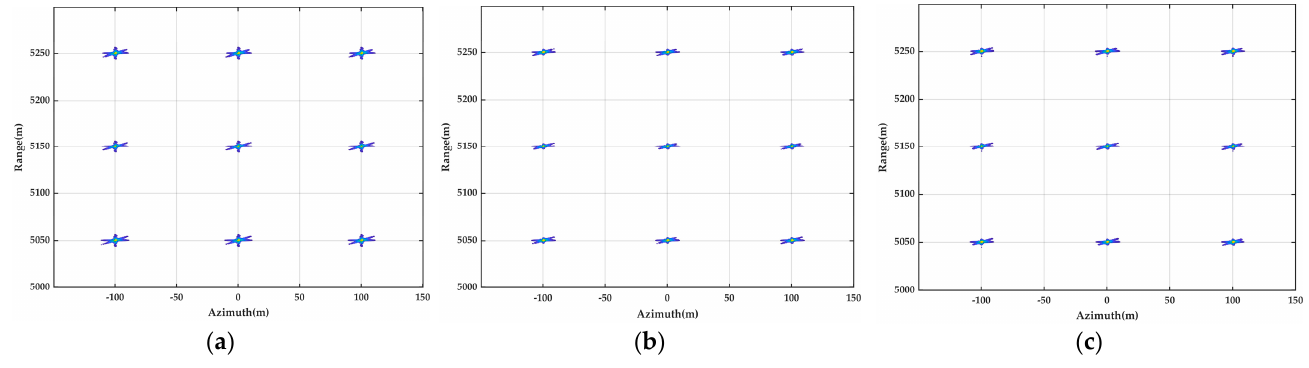
Figure 10. Imaging results of the point targets. ( a ) Bistatic BP algorithm; ( b ) Bistatic EP FFBP algorithm; ( c ) Proposed bistatic FFBP algorithm.